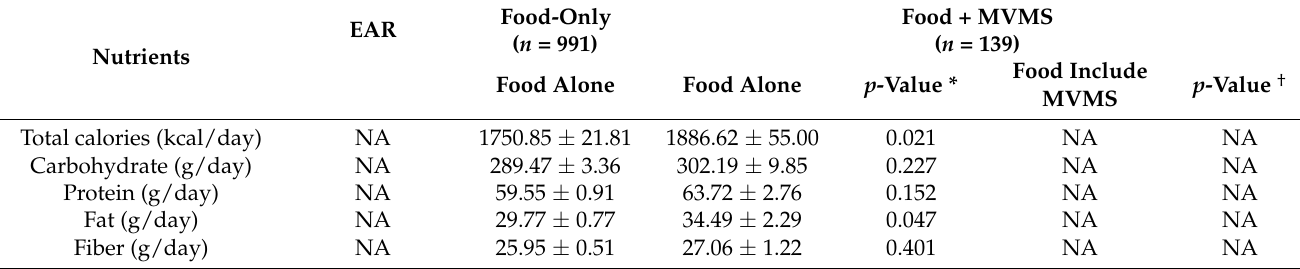
Table 2. Daily nutrient intake from food alone and included MVMS in